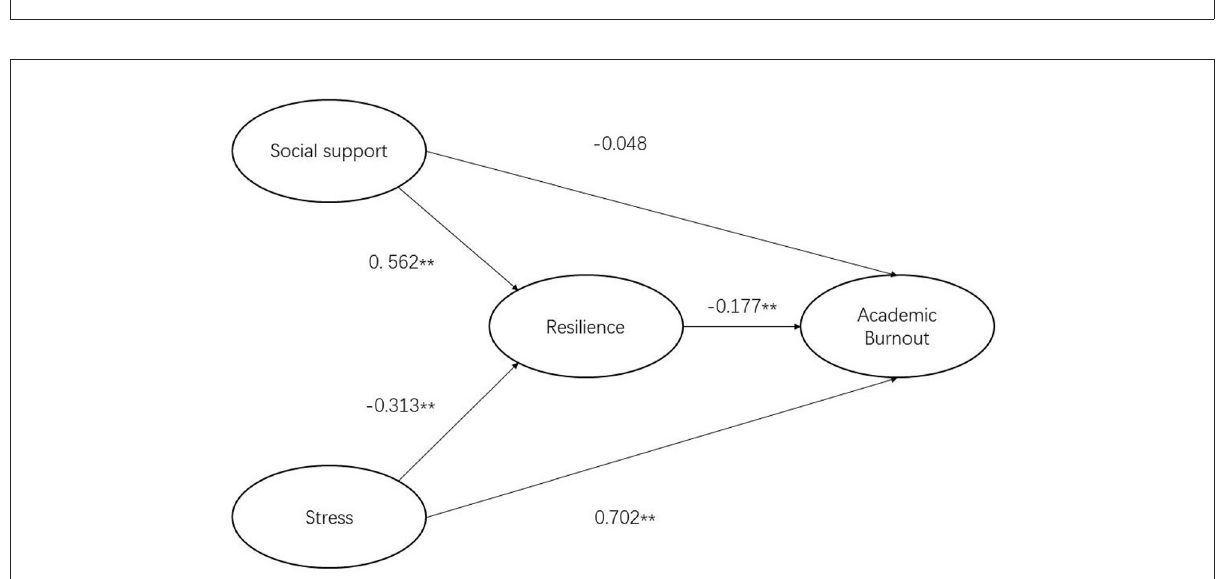
FIGURE3 SEM of the mediating role of resilience between stress, social support, and academic